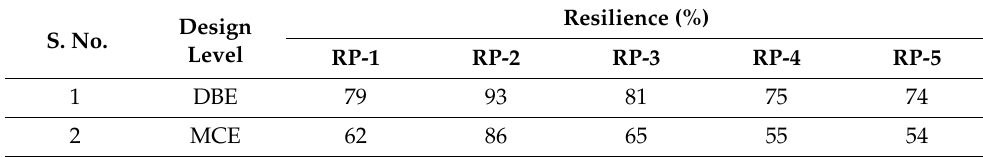
Table 17. Seismic resilience of unsymmetrical building under bidirectional loading (Case II). S. No.